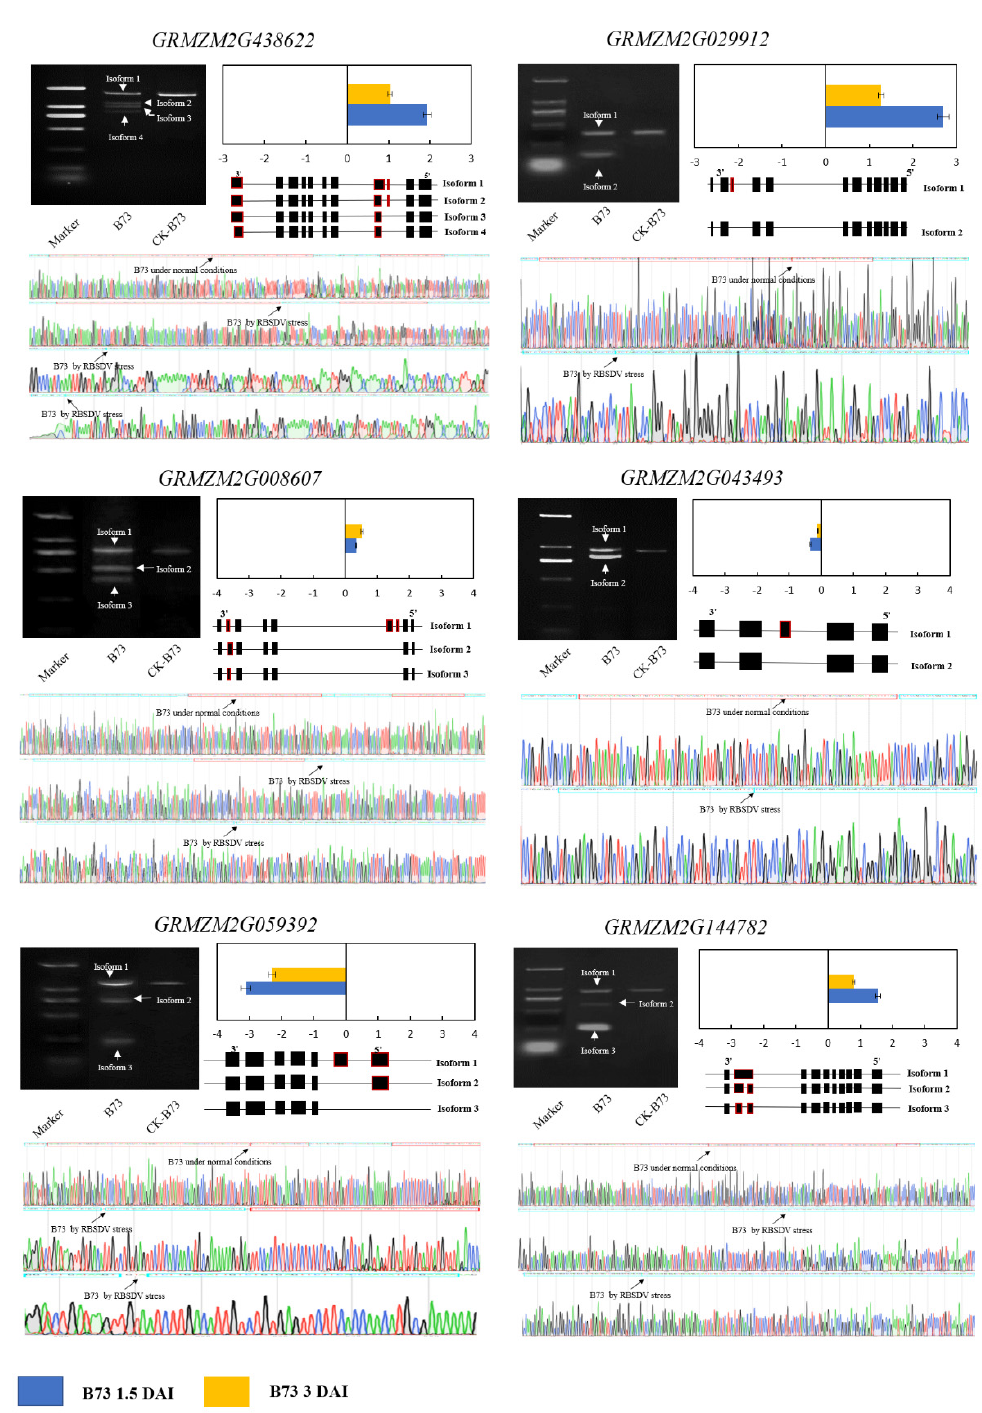
maize response to Figure 4. Experimental validation of AS events, sequencing validation, and expression levels in maize response to RBSDV.